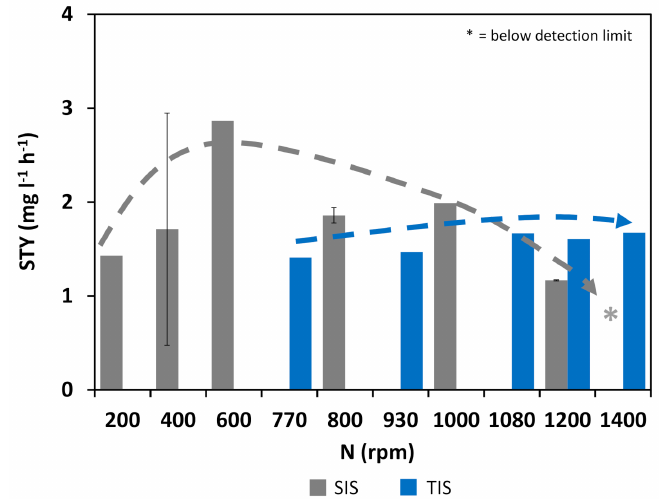
Figure 6. Antibody space time yields (STY) compared for experiments in both reactor setups: cultivation results from the SIS (grey bars); cultivation results from the TIS (blue bars). Data for 400, 800, and 1200 rpm in the SIS were averaged from three cultivations each. Dashed arrows indicate expected trends for each reactor